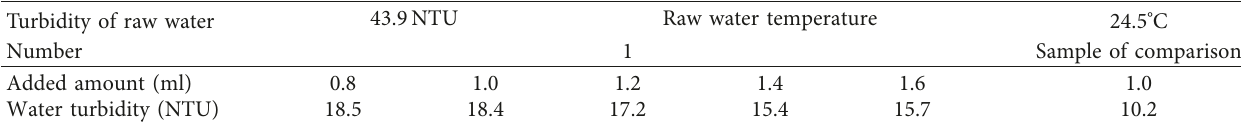
Table 3: Formula no. 1 treatment of tap water source water-related case.